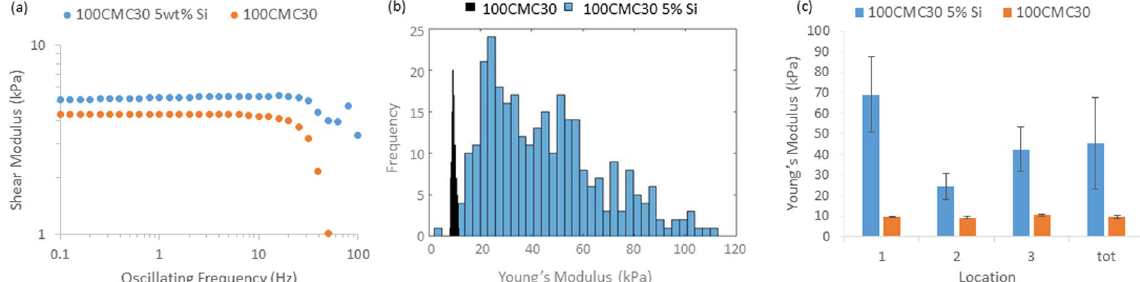
Figure 7. ( a ) Representative oscillatory frequency sweeps on 100CMC30 with and without Si beads, frequencies of oscillation were from 0.1–100 Hz at an oscillating displacement of 10 − 4 rad showing no frequency dependence (at the highest frequencies the inertia of the testing geometry dominates over the mechanics of the gel resulting in the decrease in measured modulus) and ( b ) Histogram comparing the moduli of 100 CMC30 with and without Si beads, the large spread of data with Si beads illustrating the impact heterogeneity has on local mechanical testing. All AFM experiments were conducted with an indentation depth of between 500 and 1000 nm and each curve was done over 1 s. ( c ) Summary of AFM tests performed on 100CMC30 with and without Si beads highlighting the difference resulting from heterogeneity on mechanical testing with a black line representing the moduli of CMC samples obtained by oscillatory